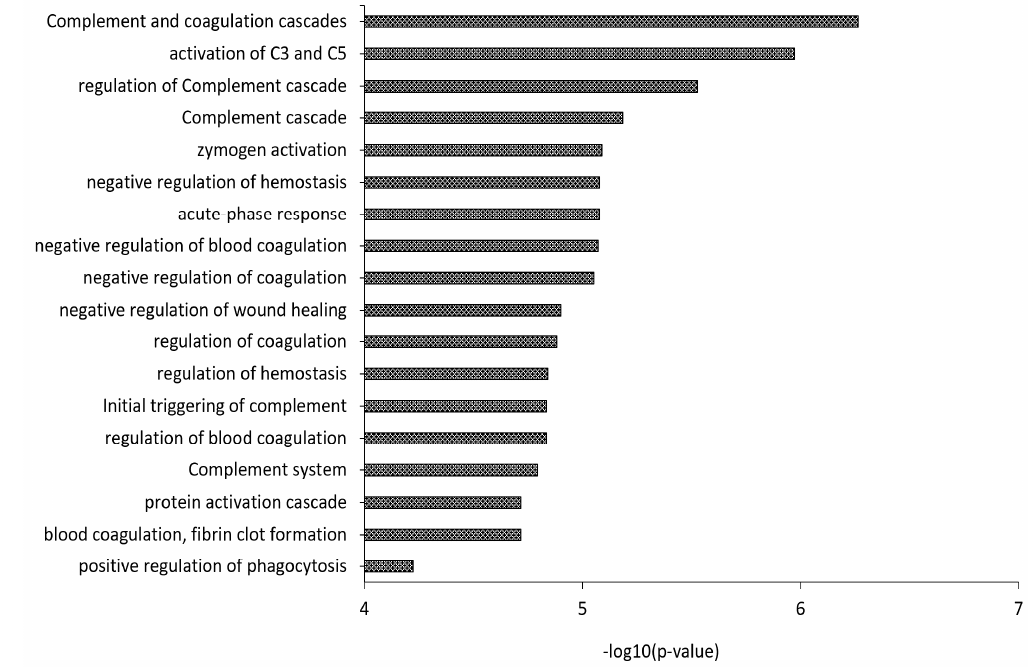
Figure 3. Gene Ontology (GO) analysis of the 21 proteins identified in this study, which are not yet included in the “likely” LDL proteins list of the Davidson’s Lab database (http://www.DavidsonLab.com, last update 24 April 2019), already reported by either Dashty et al. [25] or Bancells et al. [50] to be associated with LDL.